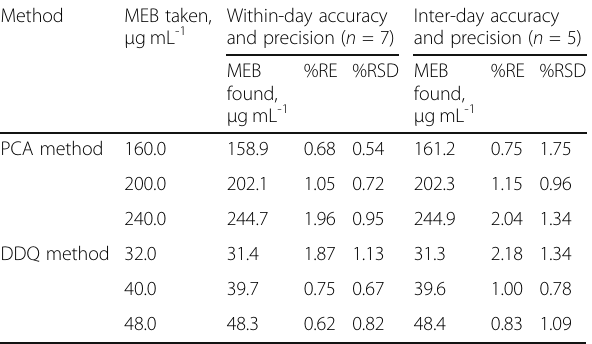
Table 5 Results of tablets (products X and Y) analysis by the PCA, DDQ and official methods and their statistical comparison Product Label analyzed claim,